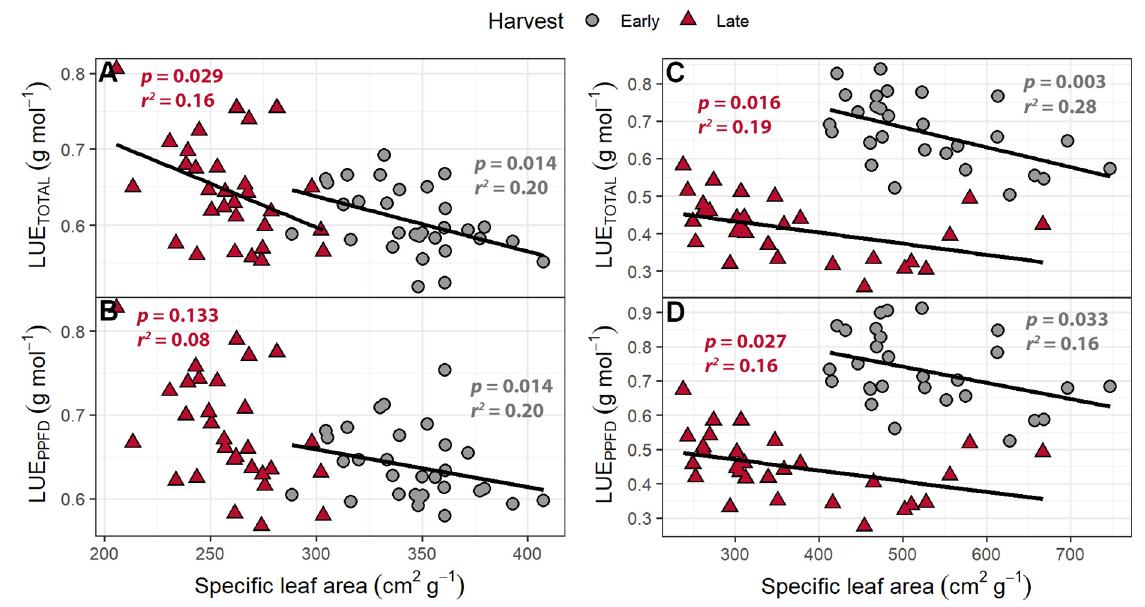
Figure 11. ( A , C ) The correlation between specific leaf area and light use efficiency of “Green Salad Bowl” lettuce ( Lactuca sativa ) calculated based on total photon flux density (LUE TOTAL ) and ( B , D ) photosynthetic photon flux density (LUE PPFD ). Plants were grown with 207 ± 13 µmol m − 2 s − 1 of white light and 4.9 to 28.0 µmol m − 2 s − 1 far-red light ( A , B ) or 111 to 245 µmol m − 2 s − 1 of white light and 4.7 to 32.8 µmol m − 2 s − 1 far-red light ( C , D ). Plants were harvested after 16 (early) or 25 days after germination (late).